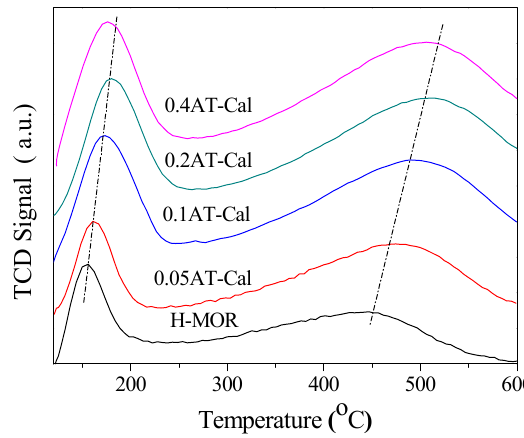
Figure 4. NH 3 -TPD spectra of the samples before and after alkali treatment.